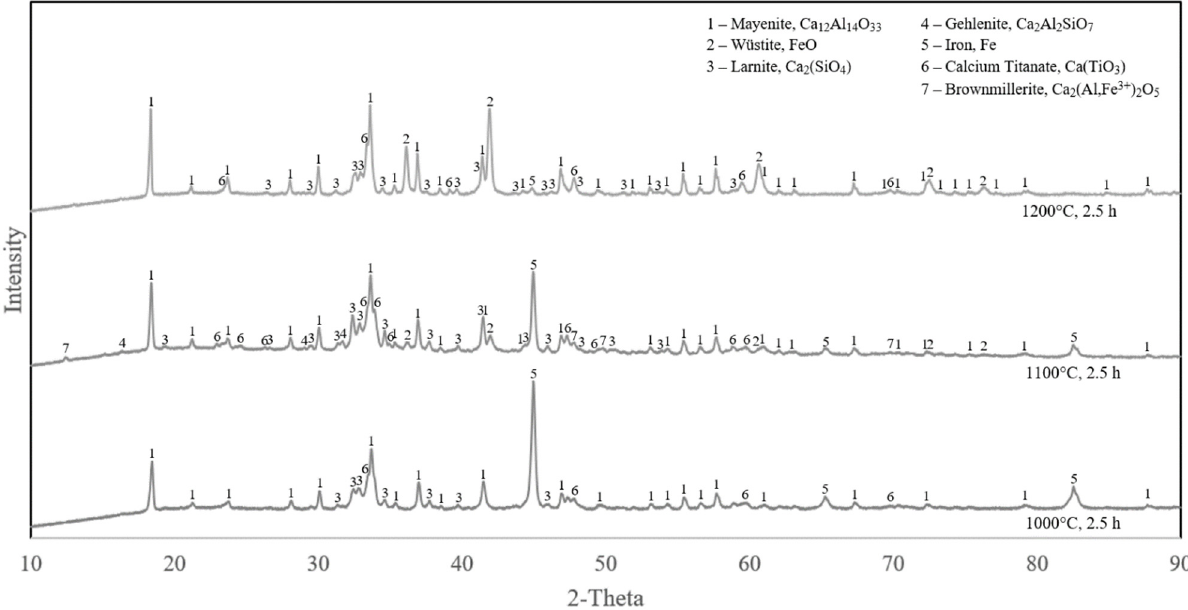
Figure 5. XRD analyses of samples reduced for 2.5 h at different temperatures (Samples 4, 7, 9).